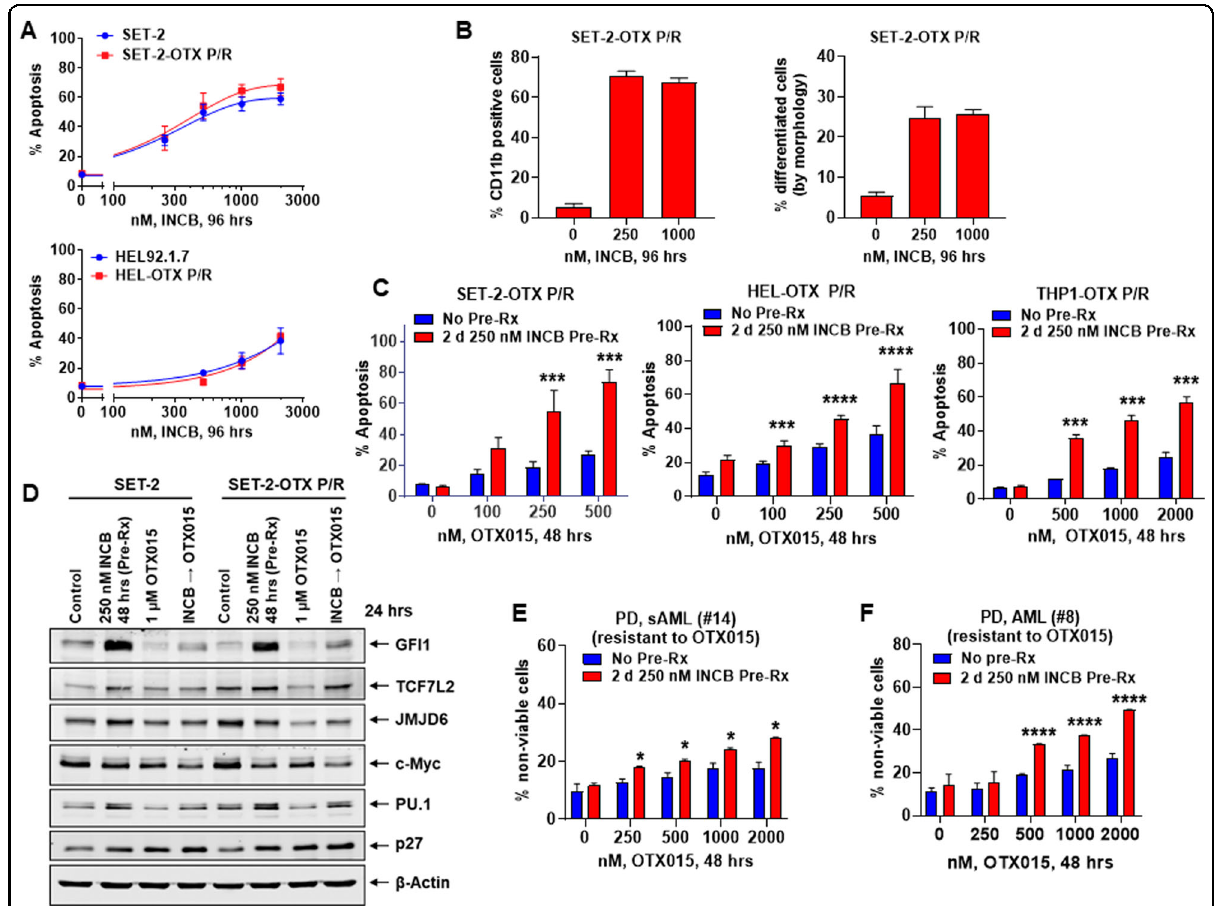
Fig. 6 LSD1i pre-treatment sensitizes BETi persister/resistant post-MPN sAML and de novo AML cells to BETi. A HEL92.1.7, HEL-OTX P/R, SET-2 and SET-2-OTX P/R cells were treated with INCB059872 for 96 h. The % of annexin V-positive, To-Pro-3 iodide-positive, apoptotic cells was determined by fl ow cytometry. Mean of three experiments + S.D. B SET-2-OTX P/R cells were treated with the indicated concentrations of INCB059872 for 96 h. Differentiated cells were assessed by CD11b fl ow cytometry and by cell morphology. Mean of three experiments + S.D. C SET-2-OTX P/R, HEL-OTX P/ R, and THP1-OTX P/R cells were treated with the indicated concentrations of OTX015 with or without 2 days of pre-treatment with 250 nM of INCB059872. The % of annexin V-positive, apoptotic cells was determined by fl ow cytometry. Mean of three experiments + S.D. *** p < 0.005, **** p < 0.001 compared to cells treated with OTX015 without INCB059872 pre-treatment (determined by a two-tailed, unpaired t -test). D Immunoblot analyses conducted on total cell lysates from SET-2 and SET-2-OTX P/R cells pre-treated with INCB059872 (48 h) and/or OTX015 (24 h), as indicated. E PD, sAML (#14) cells (ex vivo resistant to OTX015) were treated (in duplicate) with the indicated concentrations of OTX015 with or without 2 days of pre-treatment with 250 nM of INCB059872. The % of To-Pro-3 iodide-positive, nonviable cells was determined by fl ow cytometry. * p < 0.05 compared to cells treated with OTX015 without INCB059872 pre-treatment (determined by a two-tailed, unpaired t -test). F PD, AML (#8) blast cells (ex vivo resistant to OTX015) were treated (in duplicate) with the indicated concentrations of OTX015 with or without 2 days of pre-treatment with 250 nM of INCB059872. The % of To-Pro-3 iodide-positive, nonviable cells was determined by fl ow cytometry. **** p < 0.001 versus cells treated with OTX015 without INCB059872 pretreatment (determined by a two-tailed, unpaired t